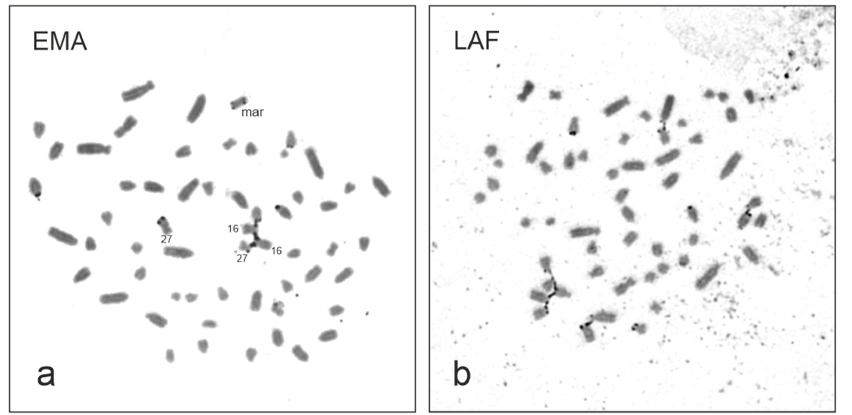
Figure 3. C ‐ banded chromosomes of E. maximus (2n = 57,XX,+mar). Figure 3. C-banded chromosomes of E. maximus (2n = 57,XX,+mar).